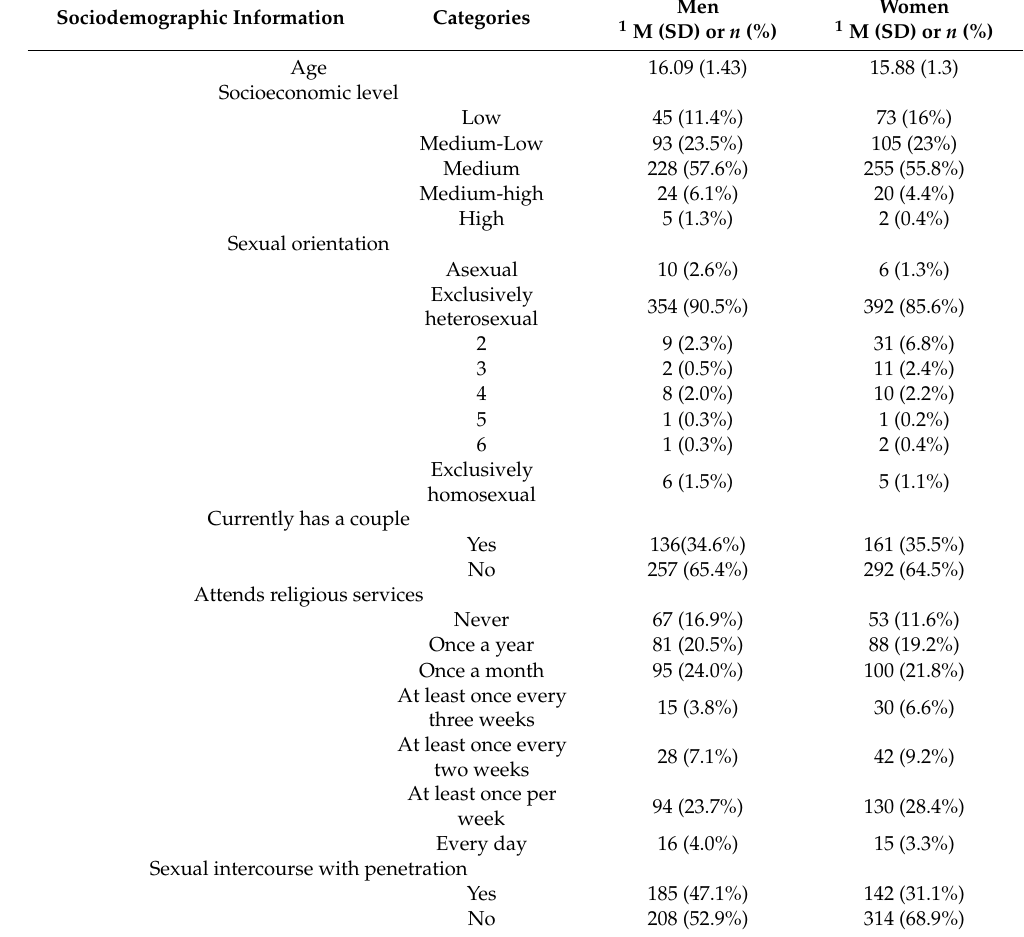
Table 1. Sociodemographic characteristics of the